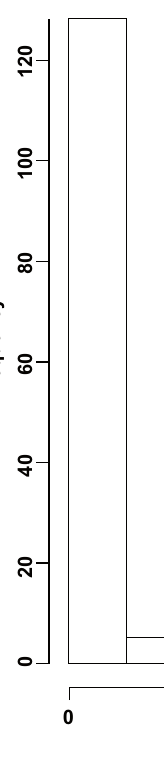
Figure 6. Distribution of total hospital stay (days). Histogram of frequencies of duration of hospitalization in the included patients.